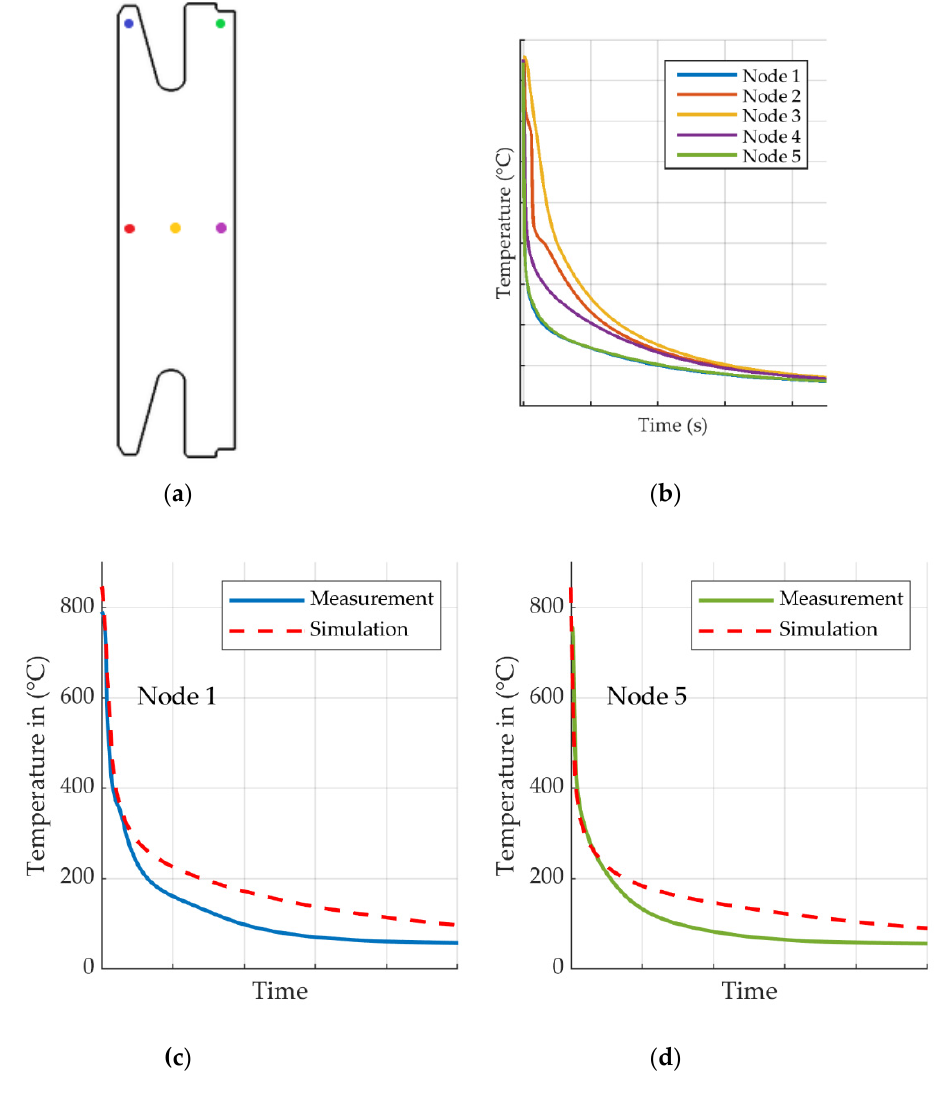
Figure 7. Simulated cooling curves at five different locations. ( a ) Thermocouple measurement and simulation evaluation location. ( b ) Simulated temperature curves. ( c ) Comparison of simulated and measured temperature curves. ( d ) Comparison of simulated and measured temperature curves.